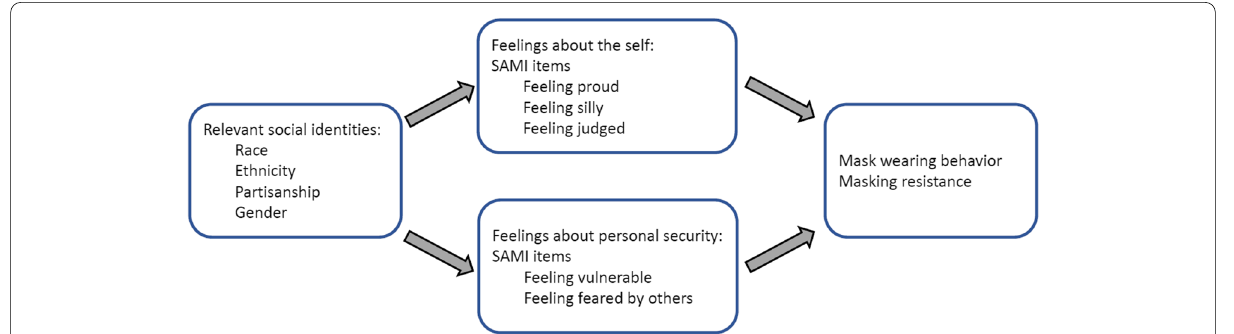
Fig. 1 Conceptual framework informing the Self-Appraisal of Masking